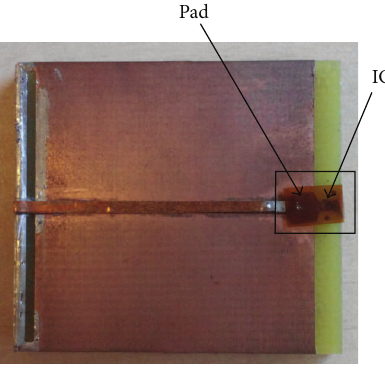
Figure 10: Fabricated prototype.